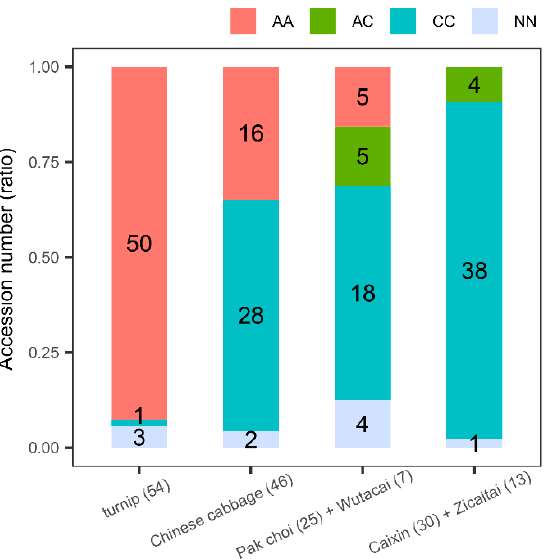
Figure 1. Frequency distribution of Pe1+58(A/C) genotypes in different B. rapa cultivar groups.